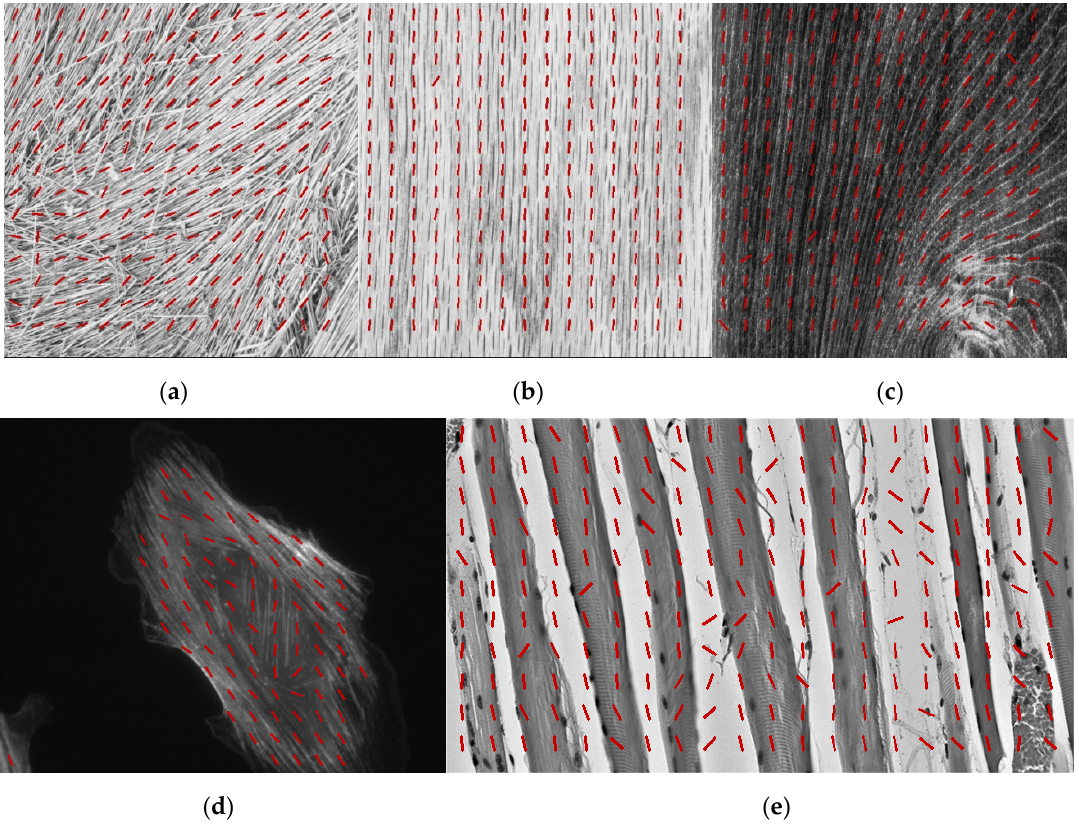
Figure 9. CNN-based directionality detection on: ( a – c ) Brodatz textures [53] obtained from publicly available image databases [59,60]; ( d ) microcopy images of actin-stained fibroblast cells, ( e ) Muscle Tissue: Skeletal Muscle Fibers [4].